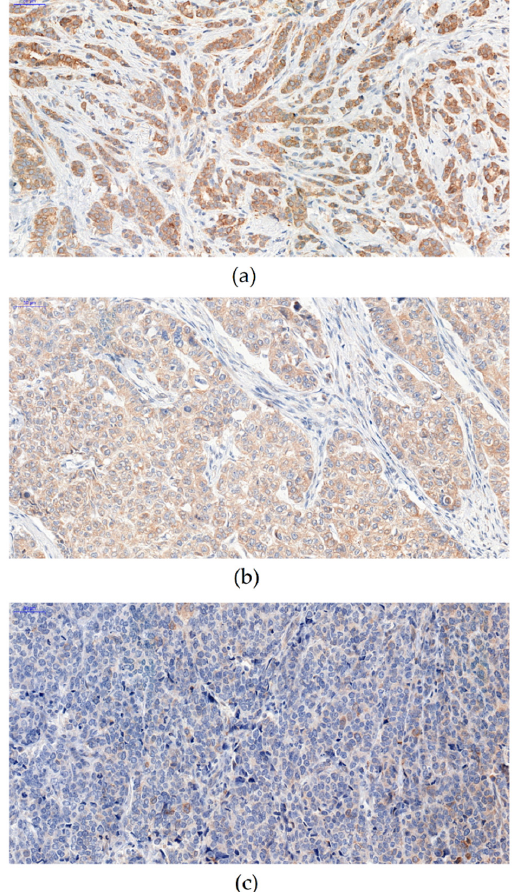
Figure 3. Immunohistochemical expression pattern of NUCB2 in IDC cells. A significantly higher expression level of NUCB2 was observed in G1 ( a ) and G2 ( b ) as compared to G3 ( c ) cases. Magni- fication 200×.